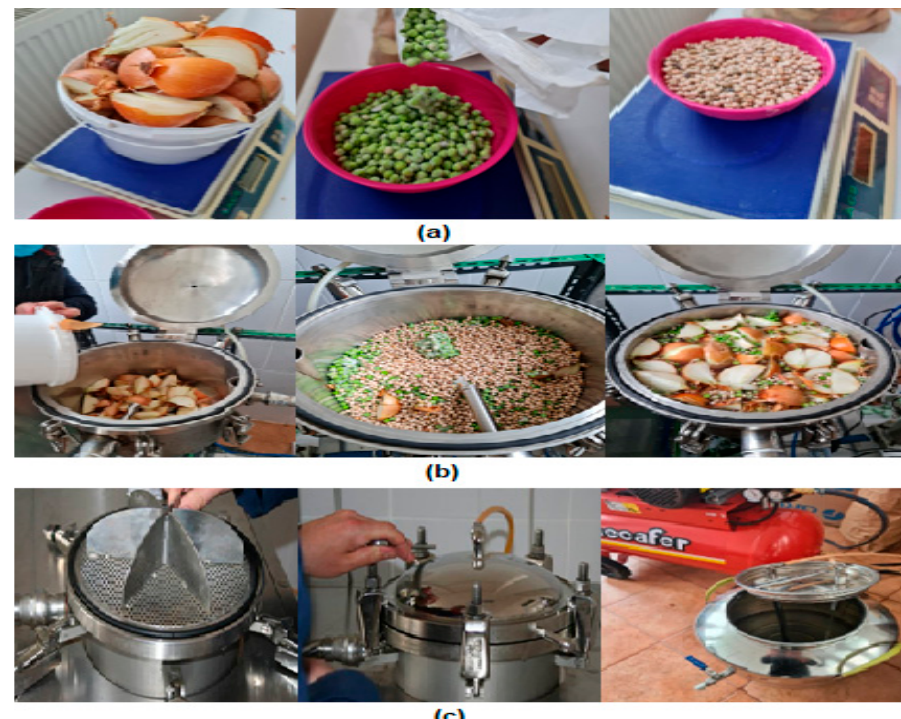
Figure 7. Description of the working method for the production of bioactive compounds: ( a ) weighing and shredding of the raw material, ( b ) adding the materials and the solvent to the extraction vessel, and ( c ) preparing the extraction and the expansion vessels.